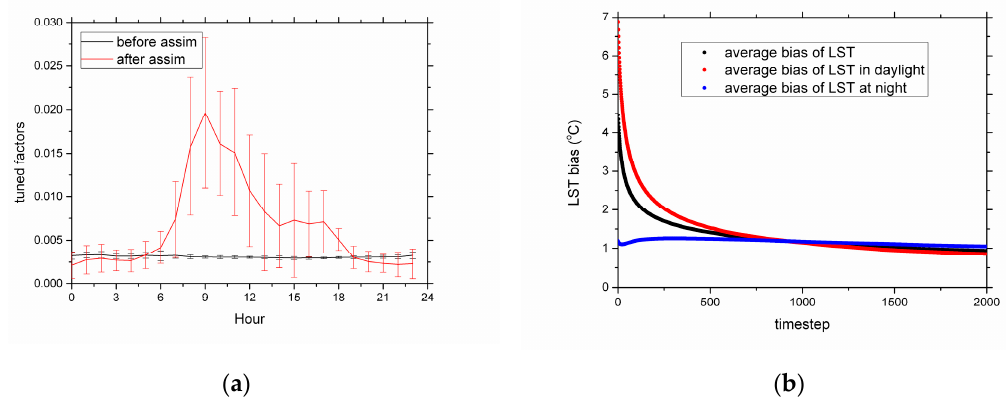
Figure 2. ( a ) Site average diurnal cycles of the tuned factor before and after assimilation; ( b ) Site average convergence processes of the assimilation algorithm.